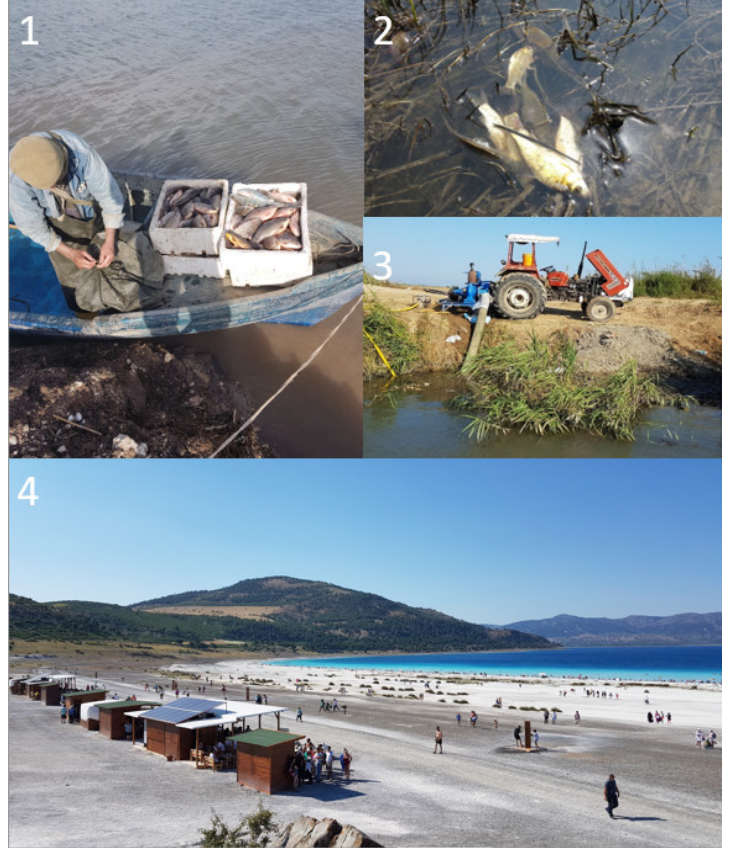
Figure 6. Pictures reporting some threats in the considered Turkish lakes: 1 : Presence of non-native species in Lake Beyşehir; 2 : Massive fish death in Lake Onaç Dam; 3 : Water extraction for agricultural activities; 4 : Tourism activities in Lake Salda.